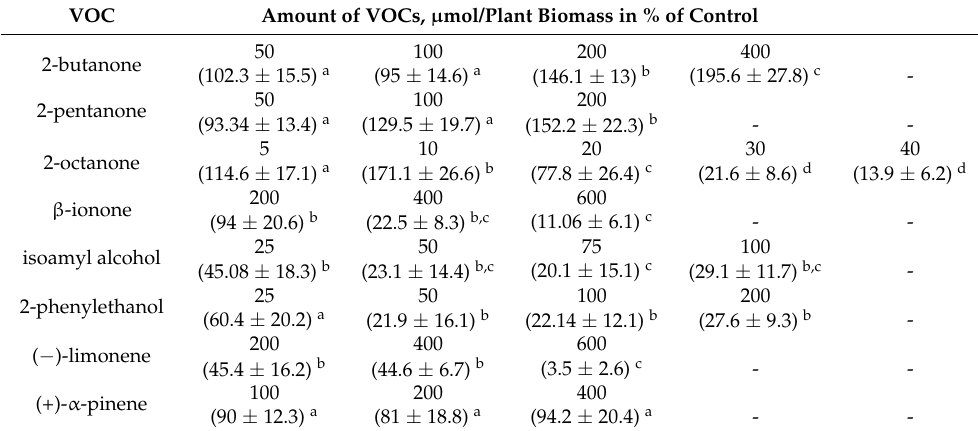
Table 2. Effect of VOCs on A. thaliana biomass